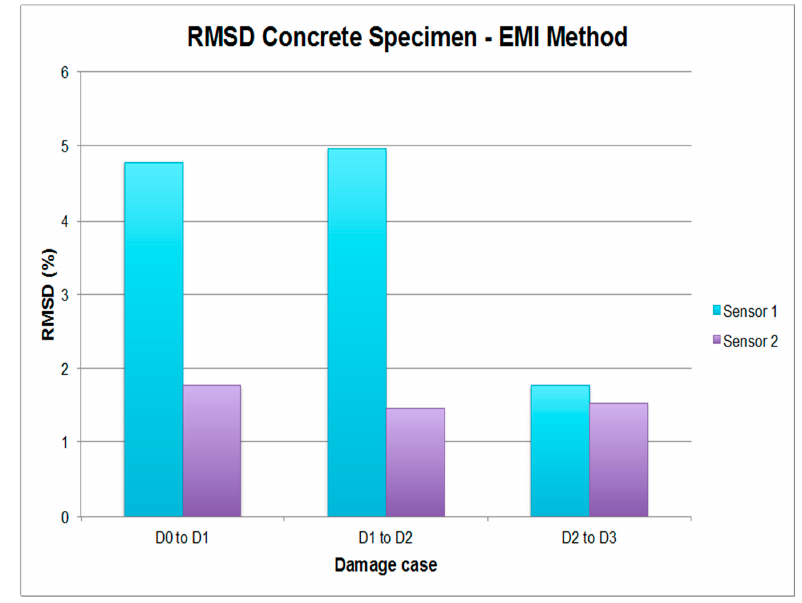
17 Figure 17. RMSD values for the concrete specimen corresponding to the EMI